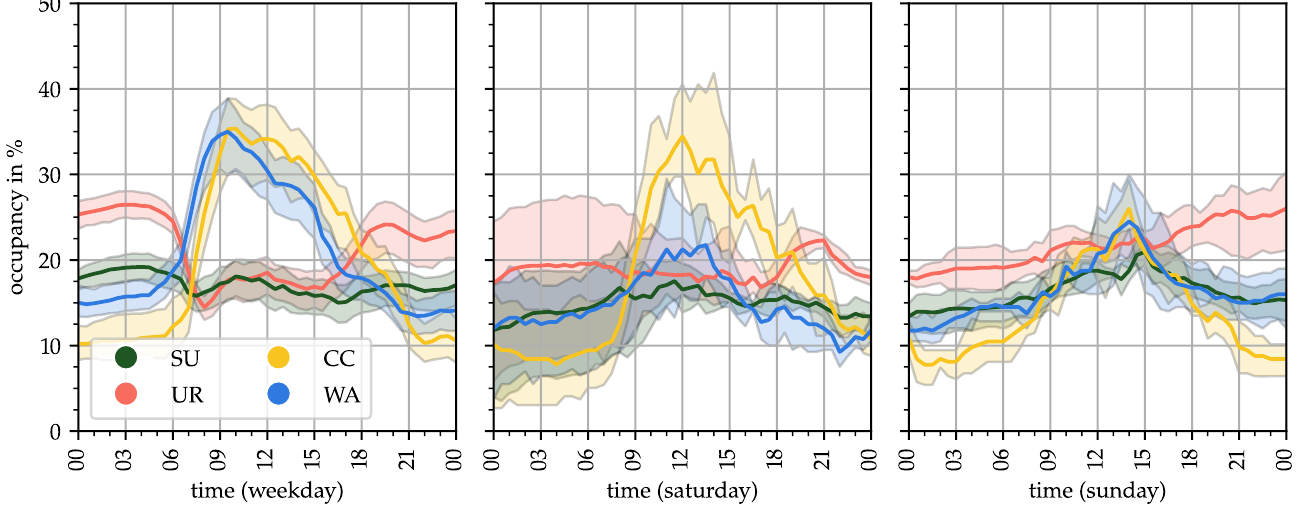
Figure 12. Occupancy per cluster, time, and day